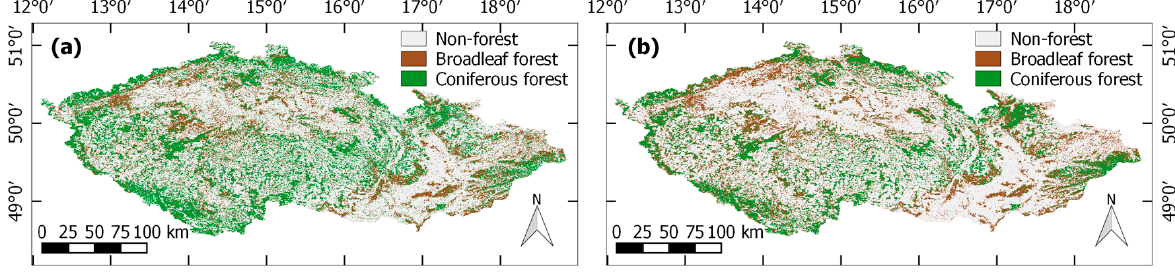
Figure 7. Detailed forest type map of the Czech Republic from ( a ) Sentinel-1, ( b ) Copernicus High Resolution Layers and ( c ) the difference map between the two datasets. Figure 8. Detailed forest type map over Sicily from ( a ) Sentinel-1, ( b ) Copernicus High Resolution Layers and ( c ) the difference map between the two datasets.